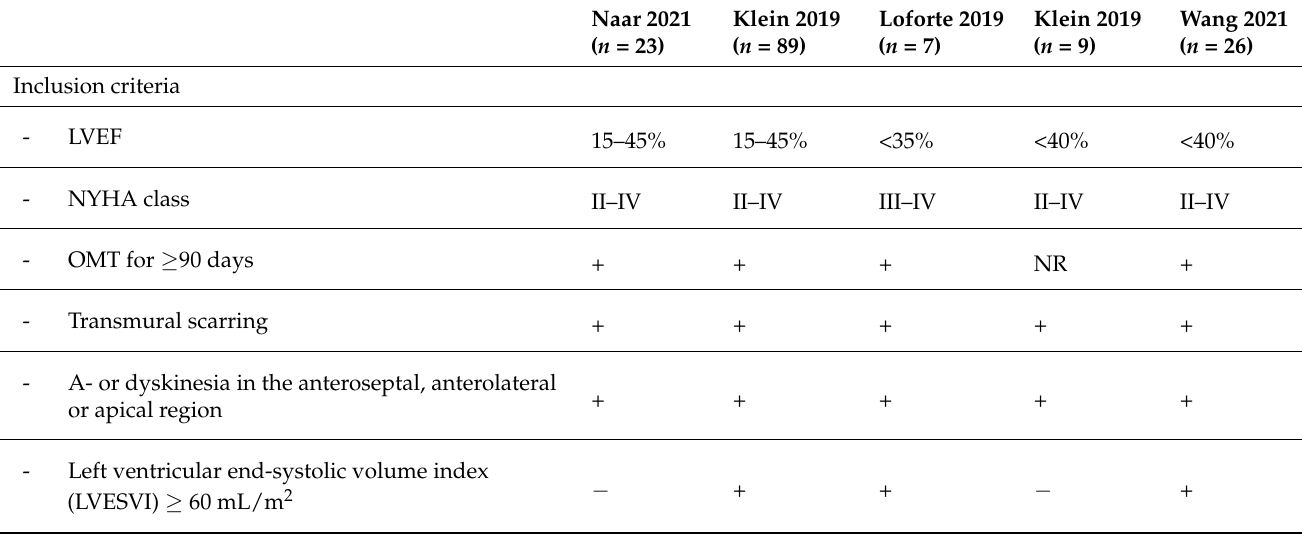
Table 1. Primary in- and exclusion criteria of previous